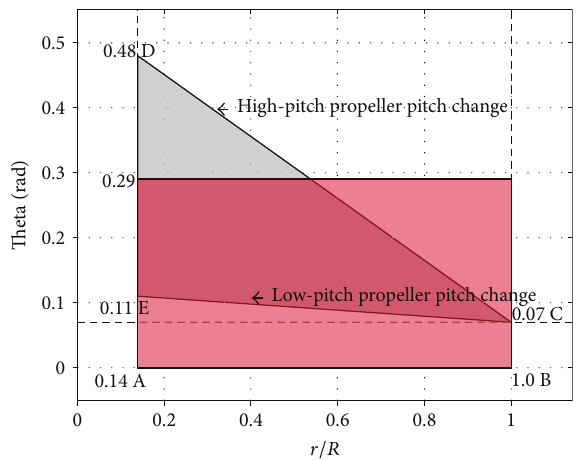
Figure 4: Twist variation along the blade